Question: Briefly state, in one sentence, what is plotted here.
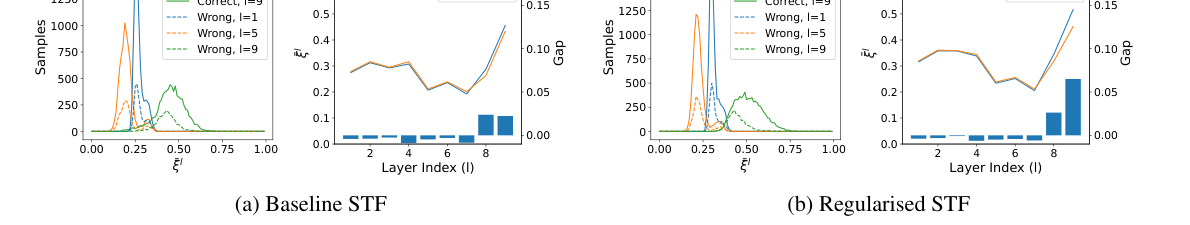
Answer: Comparision of average STF ¯ξl (over timestep) on Cifar10-DVS in distinguishing correct vs. wrong predictions. (a) illustrates the ¯ξl using the baseline method, while (b) showcases the ¯ξl after applying the regularisation technique. In both cases, the left side shows the distribution of STF over different layers, and the right side displays the average STF values for correct and wrong predictions, alongside the gap value between them.